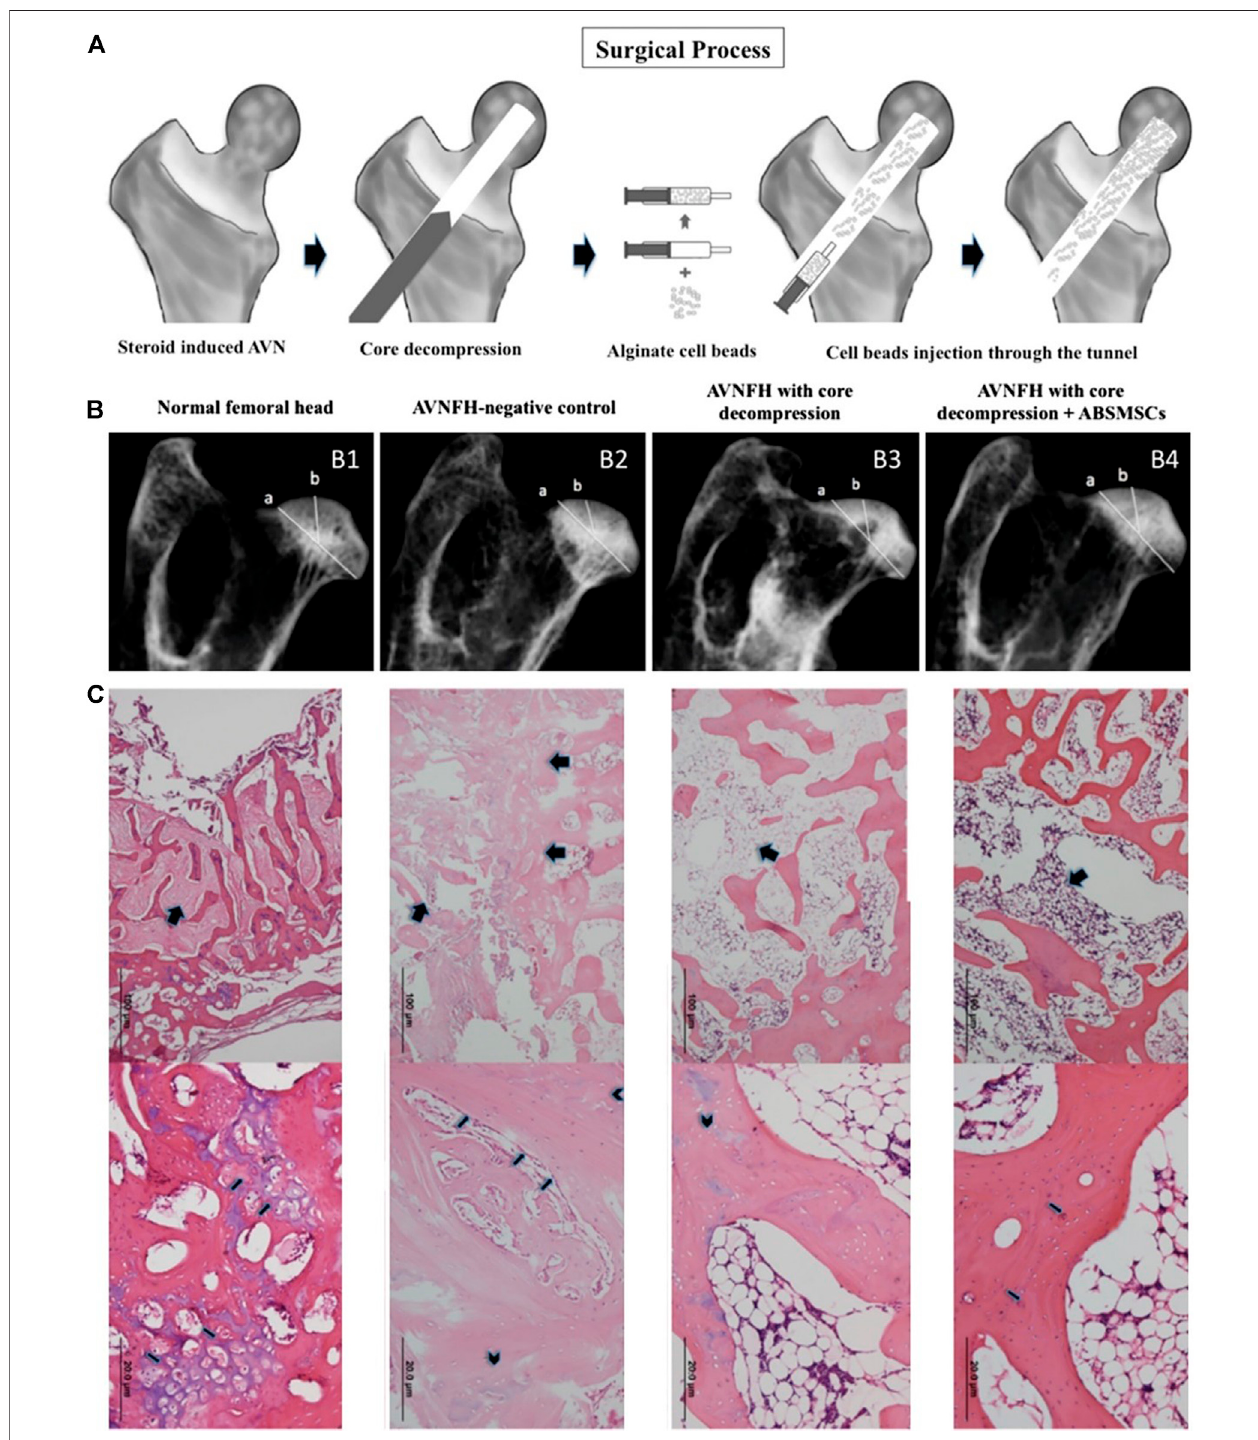
FIGURE 2 | The alginate beads loaded with SMSCs promote bone formation and angiogenesis in animal models of femoral head necrosis (Chen et al., 2014). (A) Procedures for treating femoral head necrosis in the animal model. Radiographs of harvested femoral heads (B) and histological observations (C) of different groups. Reproduced with permission (Chen et al., 2014). Copyright 2014, ELSEVIER.